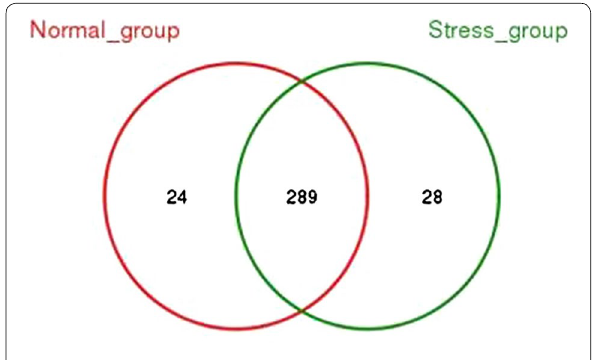
Fig. 4 Venn diagrams for overlap between normal versus stress. Venn diagrams show the overlap in all OTUs calculated at the 3% dis- similarity level. The number of species in normal and stress group are 313 and 317. The number of species shared between groups is 289. Percentage of species that are shared in stress and normal groups is 84.75%.